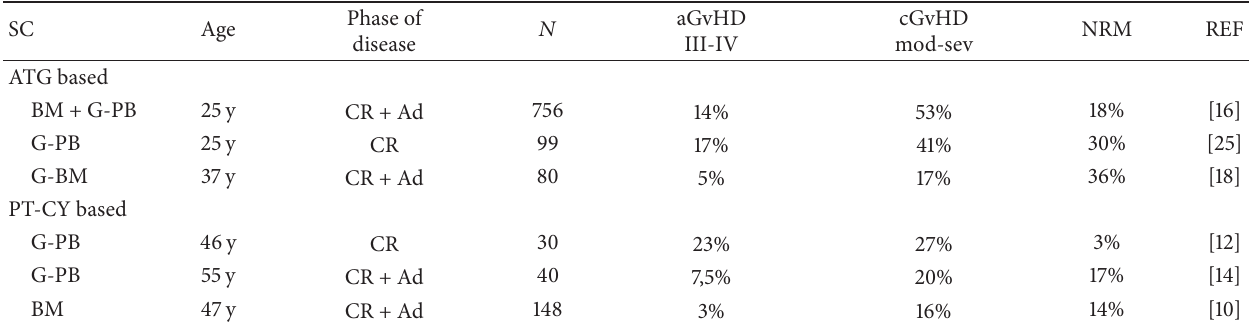
Phase of 𝑁 aGvHD disease III-IV